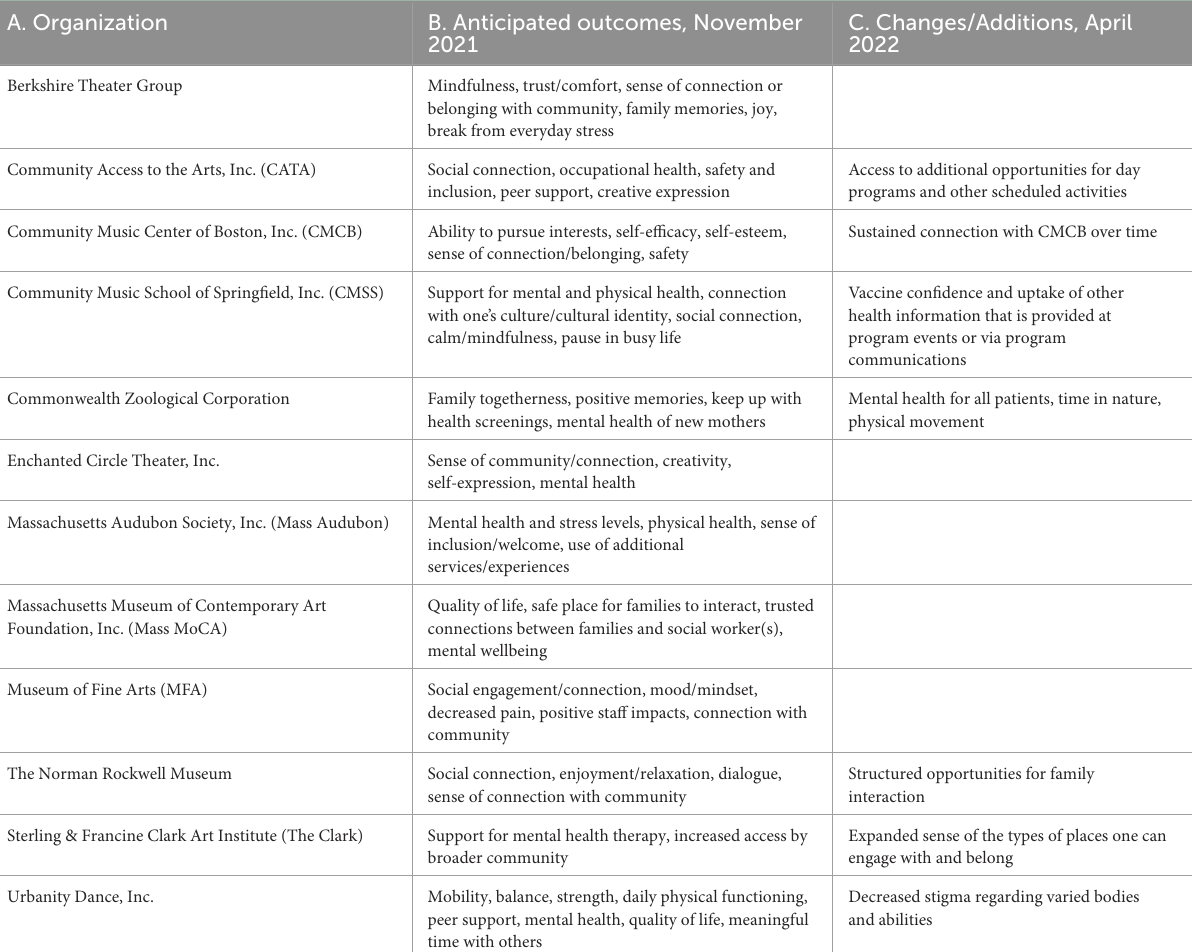
TABLE 3 Expected health